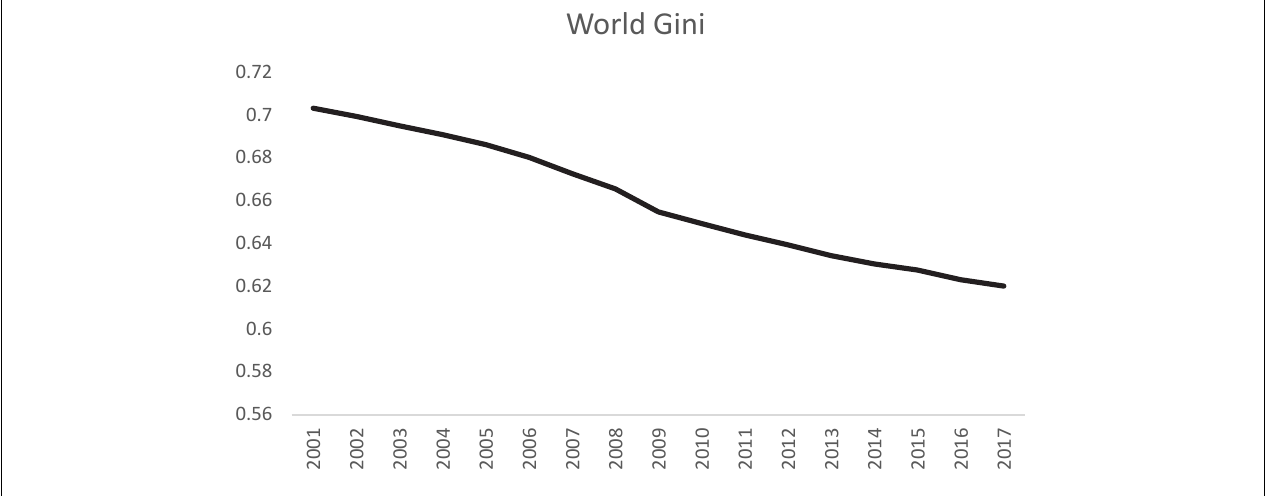
FIGURE 1 | Gini coefficient for the world, 2001 to 2017. Source: Authors’